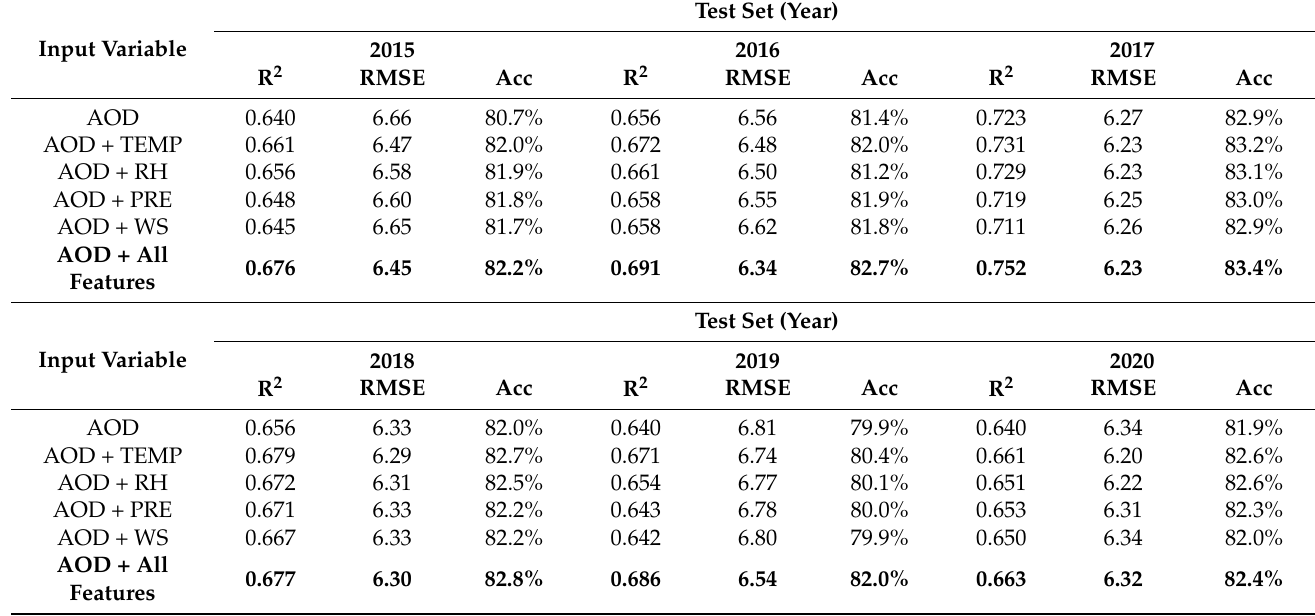
Table 6. Estimate results of BPNN model.